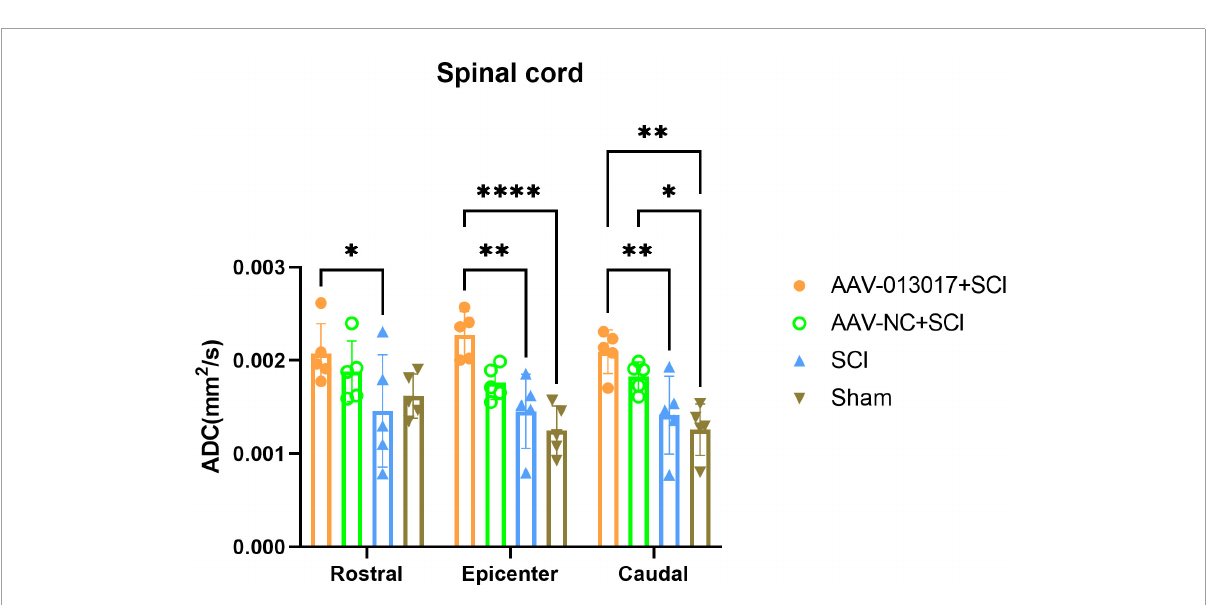
FIGURE6 Diffusion tensor imaging detection at 6 weeks after SCI. Axial diffusivity (AD) was altered in different segments of different groups ( n = 5 per group). Data are shown as means ± SD. ∗ Indicates p < 0.05, ∗∗ indicates p < 0.01, ∗∗∗∗ indicates p <